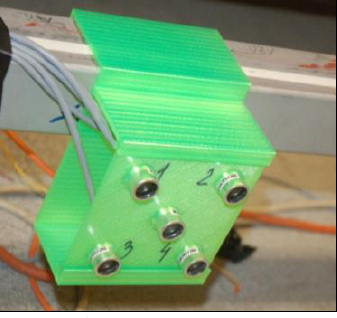
Fig. 14. The detail of the receivers organized in a